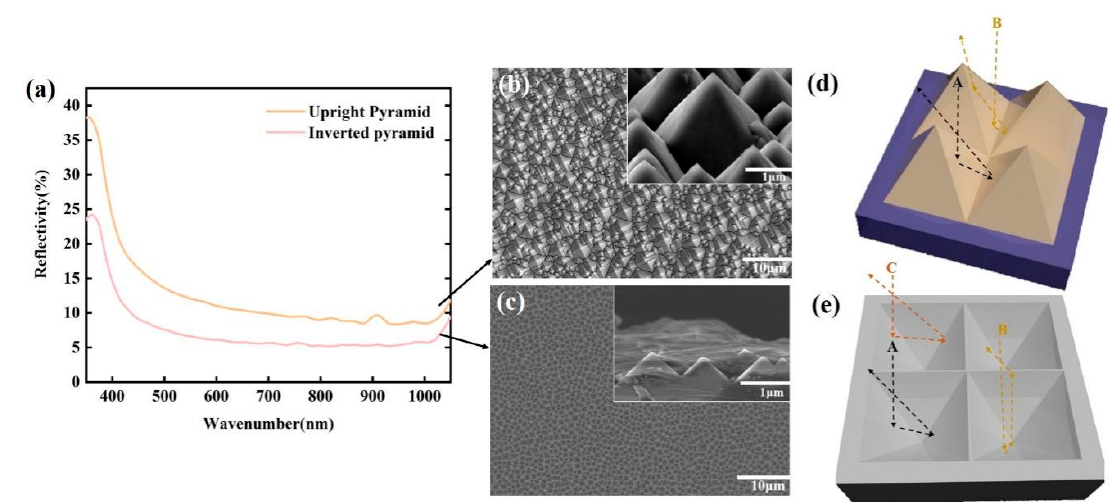
Figure 13. Reflectance spectra ( a ), SEM images ( b , c ) and possible reflection paths ( d , e ) of inverted and upright pyramids .